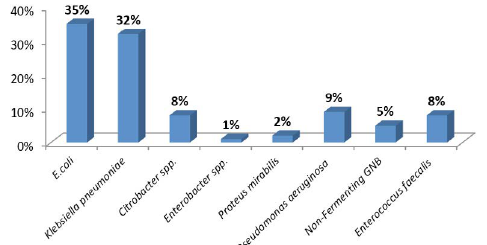
Fig. 2. Distribution of aerobic bacterial isolates from patients with CA-UTI